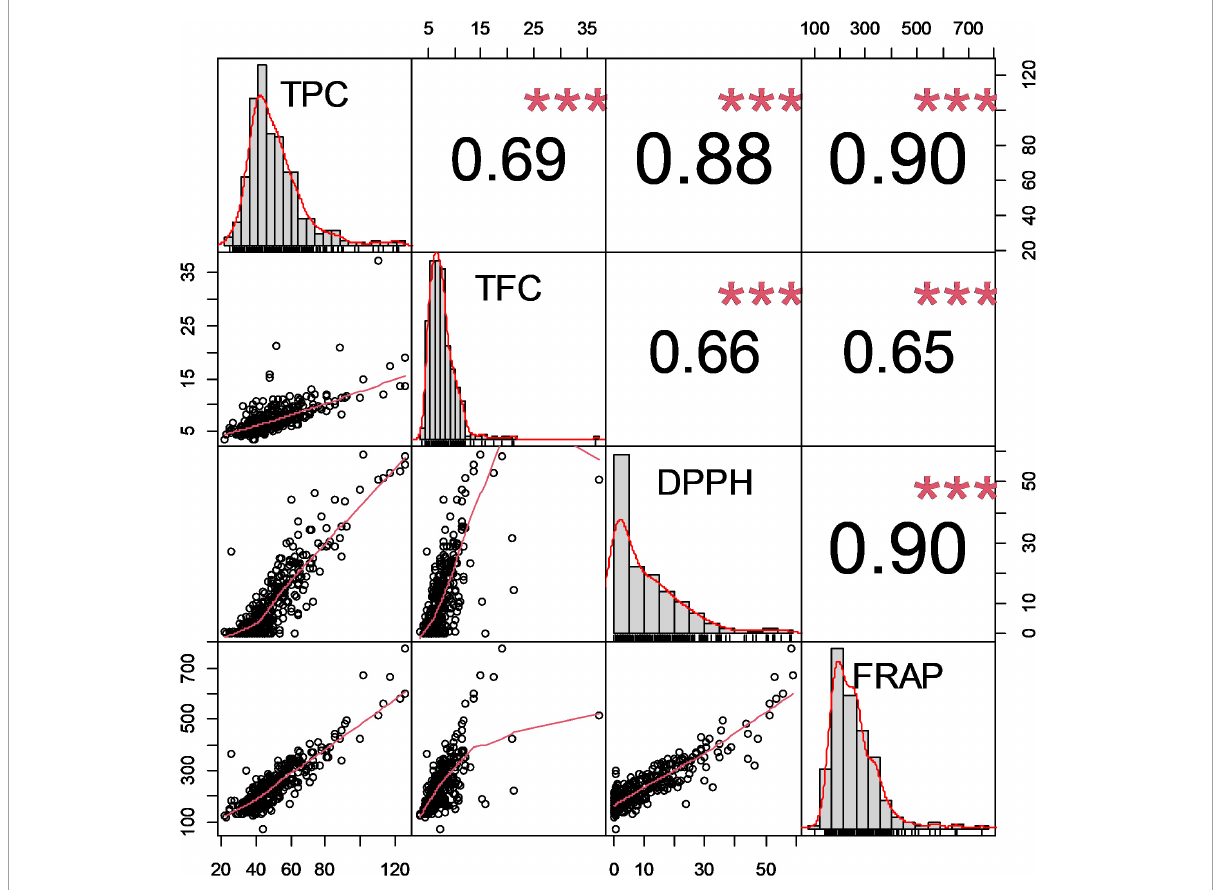
FIGURE1 Pairwise correlation coefficient analysis of the antioxidant-related traits. Numbers in the upper diagonal represent the pairwise correlation coefficient value of the antioxidant-related phenotypes. The three stars (***) indicate a significant difference at p < 0.001. The graphs on the diagonal represent the distribution histogram of the phenotypes. The graphs in the lower diagonal represent the pairwise distribution of the four antioxidant-related